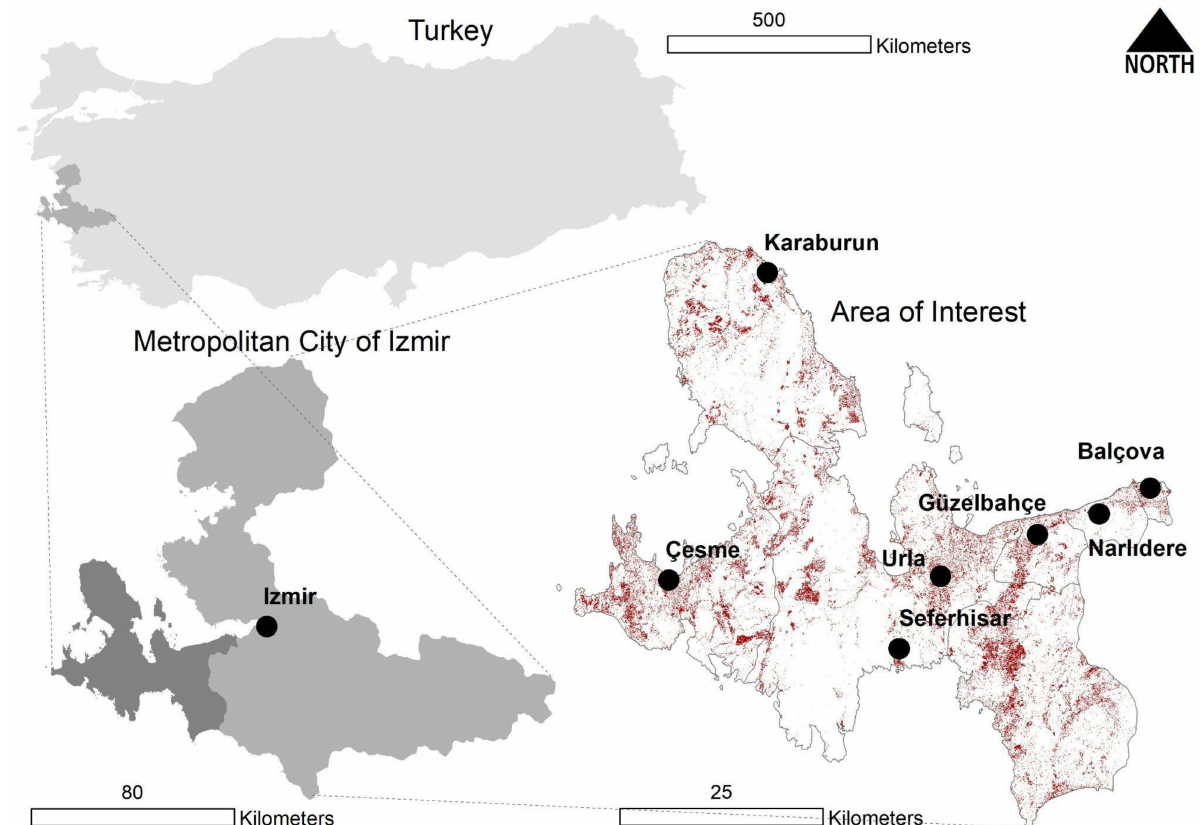
Figure 2. Localization of the Area of